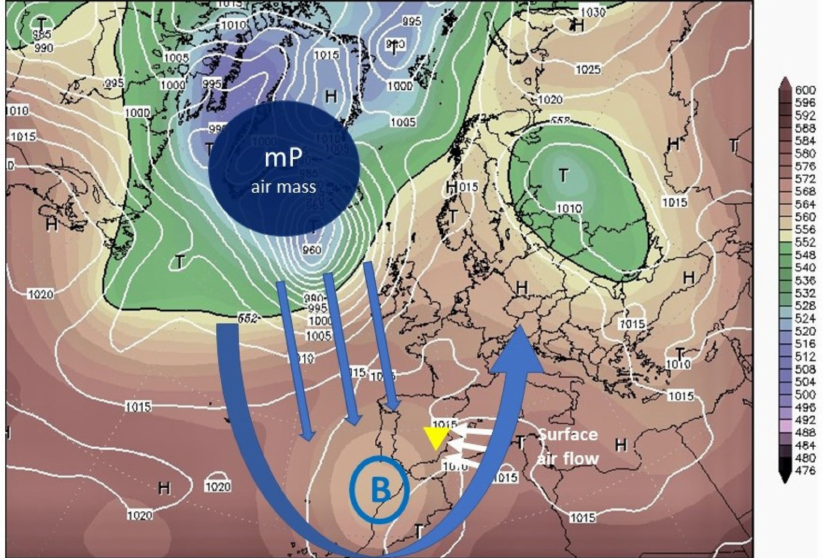
Figure 8. Standard synoptic model most frequently causing torrential rainfall episodes in the province of Alicante. Source: www.wetterzentrale.de (accessed on 22 March 2022). Own